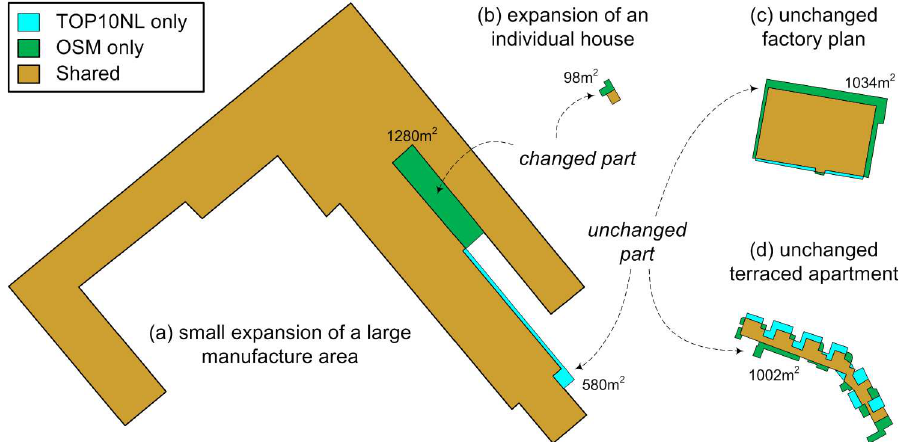
Figure 6. Difference parts by overlapping two building footprints (TOP10NL is in cyan and OSM is in green, while the shared area is in brown. Note that the relative sizes of these buildings are to scale: absolute or relative size of the difference, and the morphology or distribution of the difference should be treated differently with respect to small and large buildings. The sizes of the difference areas (green) in ( a , c , d ) are comparable, whereas the difference area in ( b ) is much smaller.